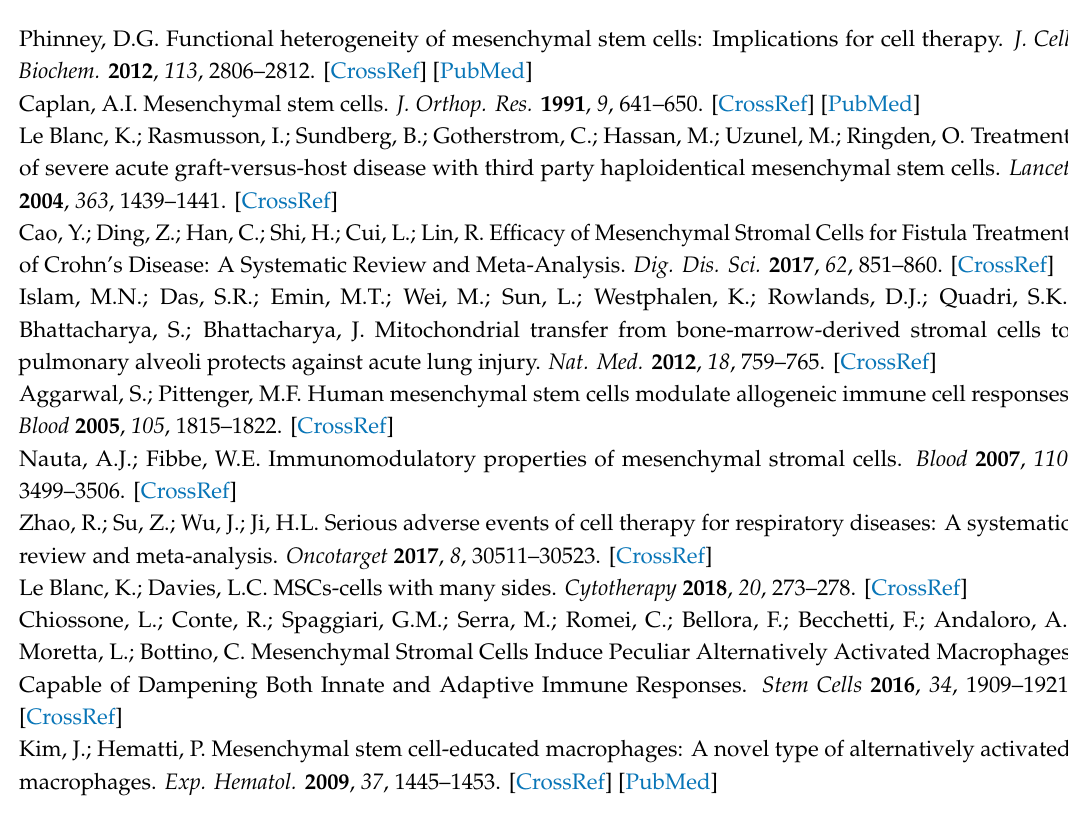
Figure S1: In vitro di ff erentiation of MSCs; Figure S2: Optimization of coculture cell ratios; Figure S3: Flow cytometry analysis of M1 and M2 macrophage markers in subject 16; Figure S4: Flow cytometry analysis of M1 and M2 markers in subject 17. Table S1: Pulmonary functional results; Table S2: Laboratory results; Table S3: Peripheral blood lymphocyte phenotype; Table S4: Summary of clinical data of subjects 16 and 17; Table S5: BAL counts and peripheral blood lymphocyte phenotype in subjects 16 and